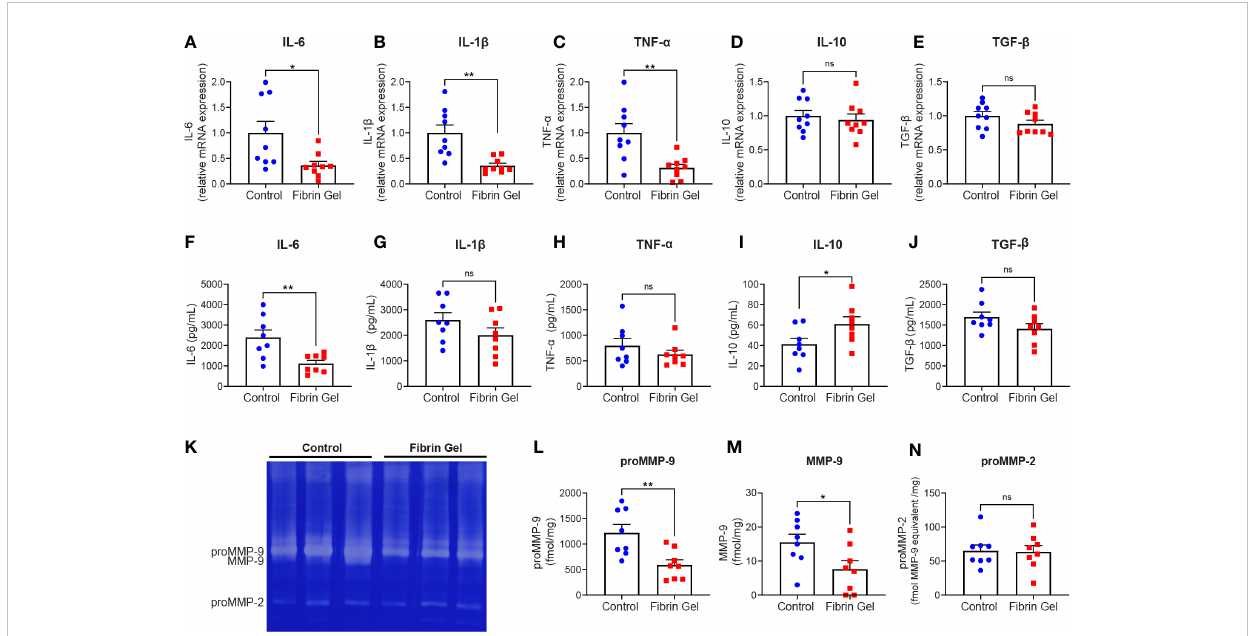
FIGURE 2 Effect of fi brin hydrogel on cytokine and gelatinase expression in skin wounds. Cytokines and gelatinases were analyzed 3 days postinjury in wounds treated with fi brin hydrogel (Fibrin Gel) and in wounds left untreated (Control). mRNA expression of IL-6 (A) , IL1- b (B) , TNF- a (C) , IL-10 (D) and TGF- b (E) were determined by qPCR. Concentrations of IL-6 (F) , IL-1 b (G) , TNF- a (H) , IL-10 (I) and TGF- b (J) were determined in wound homogenate by ELISA. Gelatin zymography analysis (K) and quanti fi cation of gelatinase proteoform expression was done by scanning analysis of pro-MMP-9 (L) , activated MMP-9 (M) and proMMP-2 (N) . *p<0.05, **p<0.01. Each symbol represents the data from a single mouse. Data are shown as mean ± SEM. ns, not signi fi